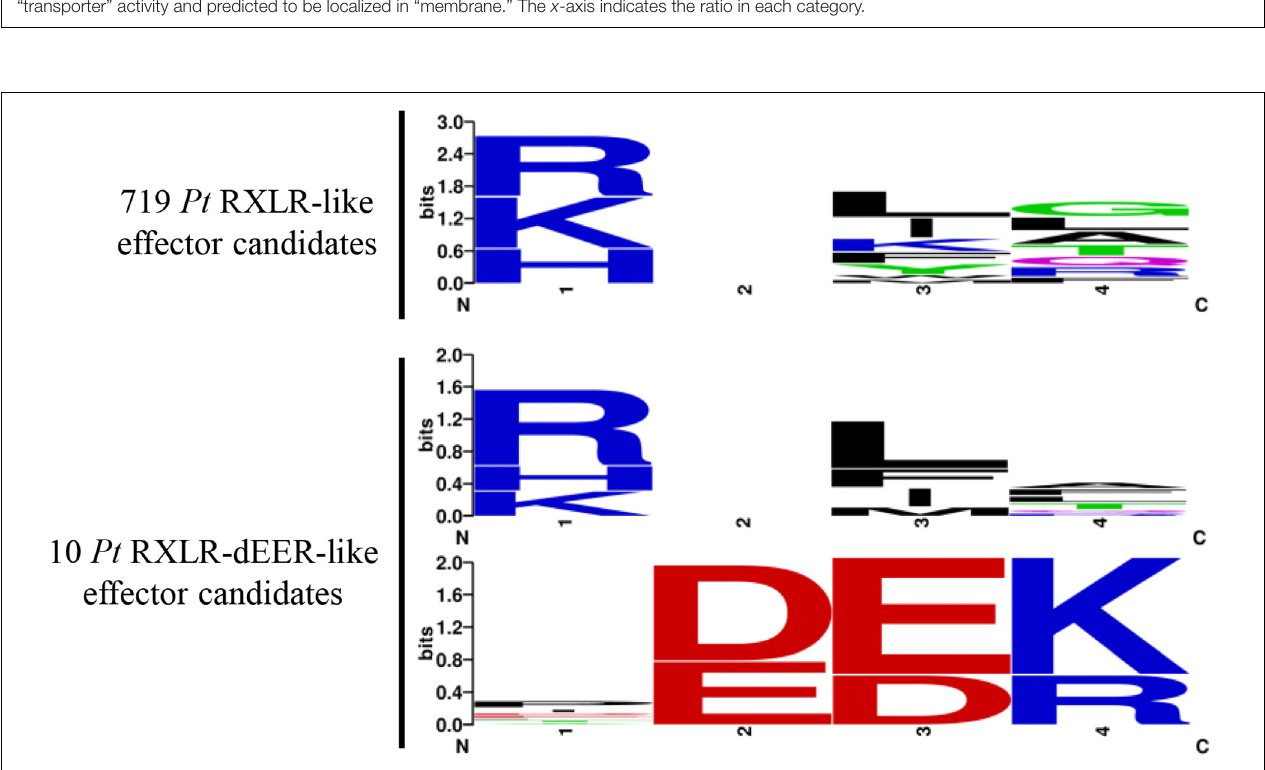
FIGURE 3 | Hidden Markov models for the conserved regions of Pt RXLR-like effector candidates identified in the current study. A total of 719 RXLR-like effector candidates were identified from the wheat leaf rust fungus, including 10 proteins containing a complete RXLR-dEER-like motif. Hidden Markov models for the conserved regions of 719 RXLR-like and 10 RXLR-dEER-like effector candidates were generated using Weblogo.